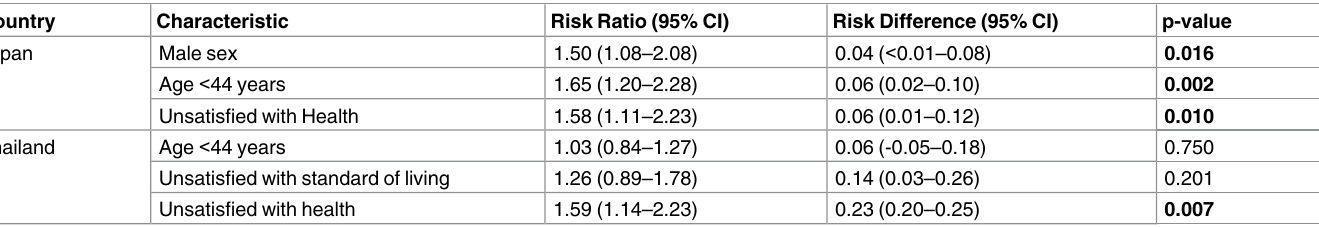
Table 4. Multivariate regression models for lower trust (trust ‘not at all’ or ‘not much’) in Press/Newspapers in each country. Country